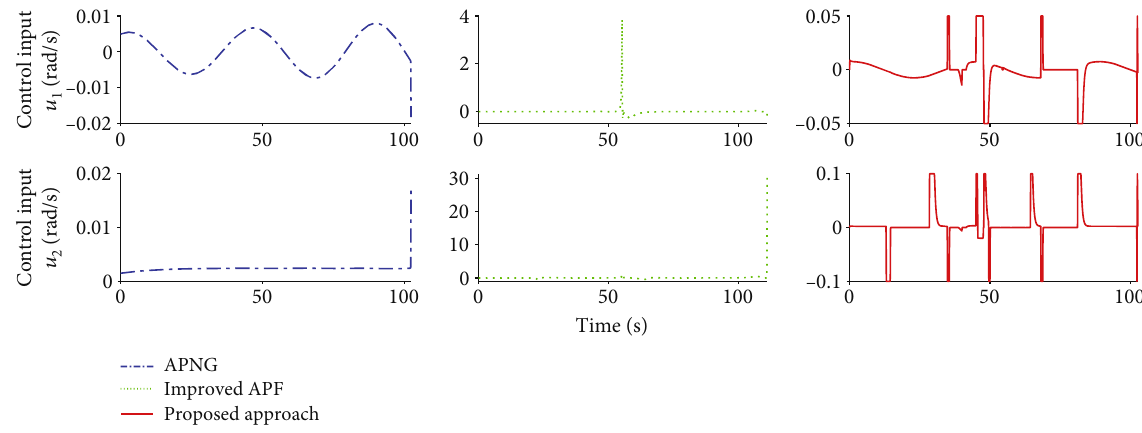
Figure 22: Changes of control inputs in case